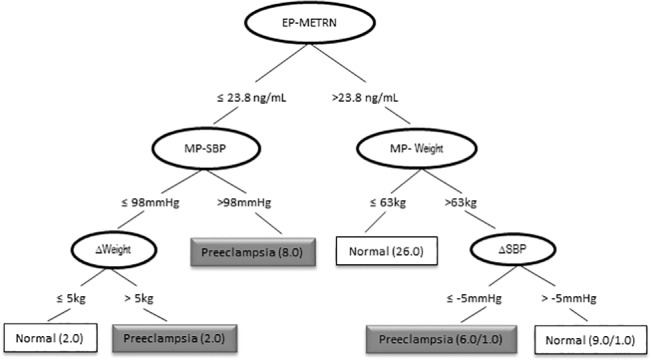
Classifier model based on decision trees.Decision nodes are represented by circles. Decision nodes show the significant variables used to perform the classification: EP-METRN (METRN levels in early pregnancy), MP-SBP (systolic blood pressure in middle pregnancy), MP-Weight (weight in middle pregnancy), ∆Weight (delta of weight between middle and early pregnancy: ∆Weight = MP.weight–EP.weight) and ∆SBP (Delta of Systolic Blood Pressure between middle and early pregnancy: ∆SBP = MP.SBP–EP.SBP). Each branch represents a test given to the decision node. Leaf nodes are represented by squares. Leaf nodes show the class in which a patient is classified (normal or preeclampsia). Leaf nodes also show the total of women from the cohort that were properly classified / total of women from the cohort misclassified.